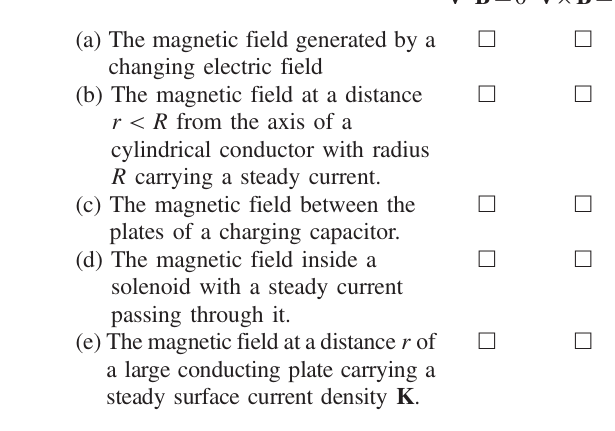
FIG. 10. Post-test field 3.